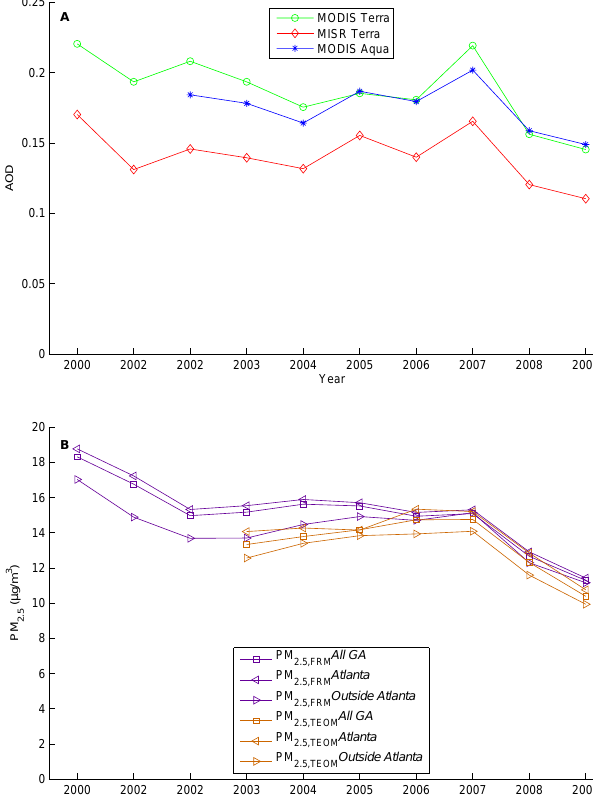
Fig. 8. Time series of multi-year means for satellite AOD and PM 2 . 5 datasets.The units for all PM 2 . 5 are µgm − 3 .